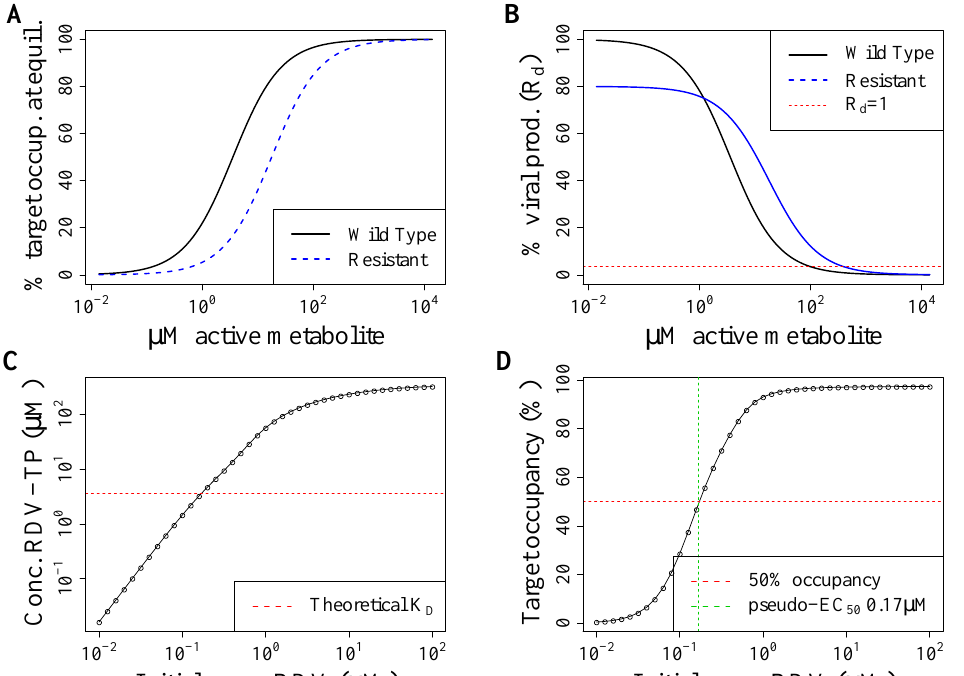
Figure 2. Pharmacodynamic model. ( A ) Target occupancy at equilibrium depending on RDV-TP concentration as calculated with Equation (2). We assume that a resistant strain has a five-fold reduced K D . ( B ) Resulting viral production rate (and therefore R d , see Equation (3)) relative to the rate in the absence of drugs. Here, we assume the same parameters as in ( A ), and additionally set a fitness cost for the resistant strain of 20%. ( C , D ): Model validation by simulating “pseudo-EC 50 ” for remdesivir in vitro. This figure shows simulations of in vitro experiments to determine the half- maximal suppression of viral production (EC 50 ) in cell culture when supplying RDV to the medium of cells grown in culture (i.e. extracellular RDV). ( A ) Intracellular RDV-TP concentrations depending on the extracellular RDV concentration (black line) obtained with our pharmacokinetic model described in Section 2.1. The dashed red line indicates the K D of RDV-TP to polymerase binding. ( B ) Target occupancy depending on extracellular RDV concentrations obtained with Equation (2) (black line). The dashed red line indicates 50% target occupancy. The dashed green line indicates the EC 50 as obtained by fitting a log-logistic function to the calculated data shown in this figure with the R package